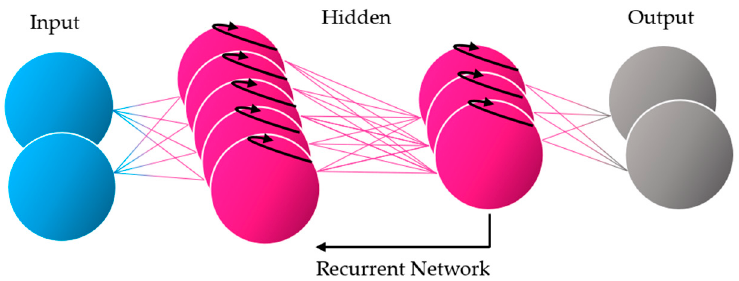
Figure 8. Recurrent neural network architecture.